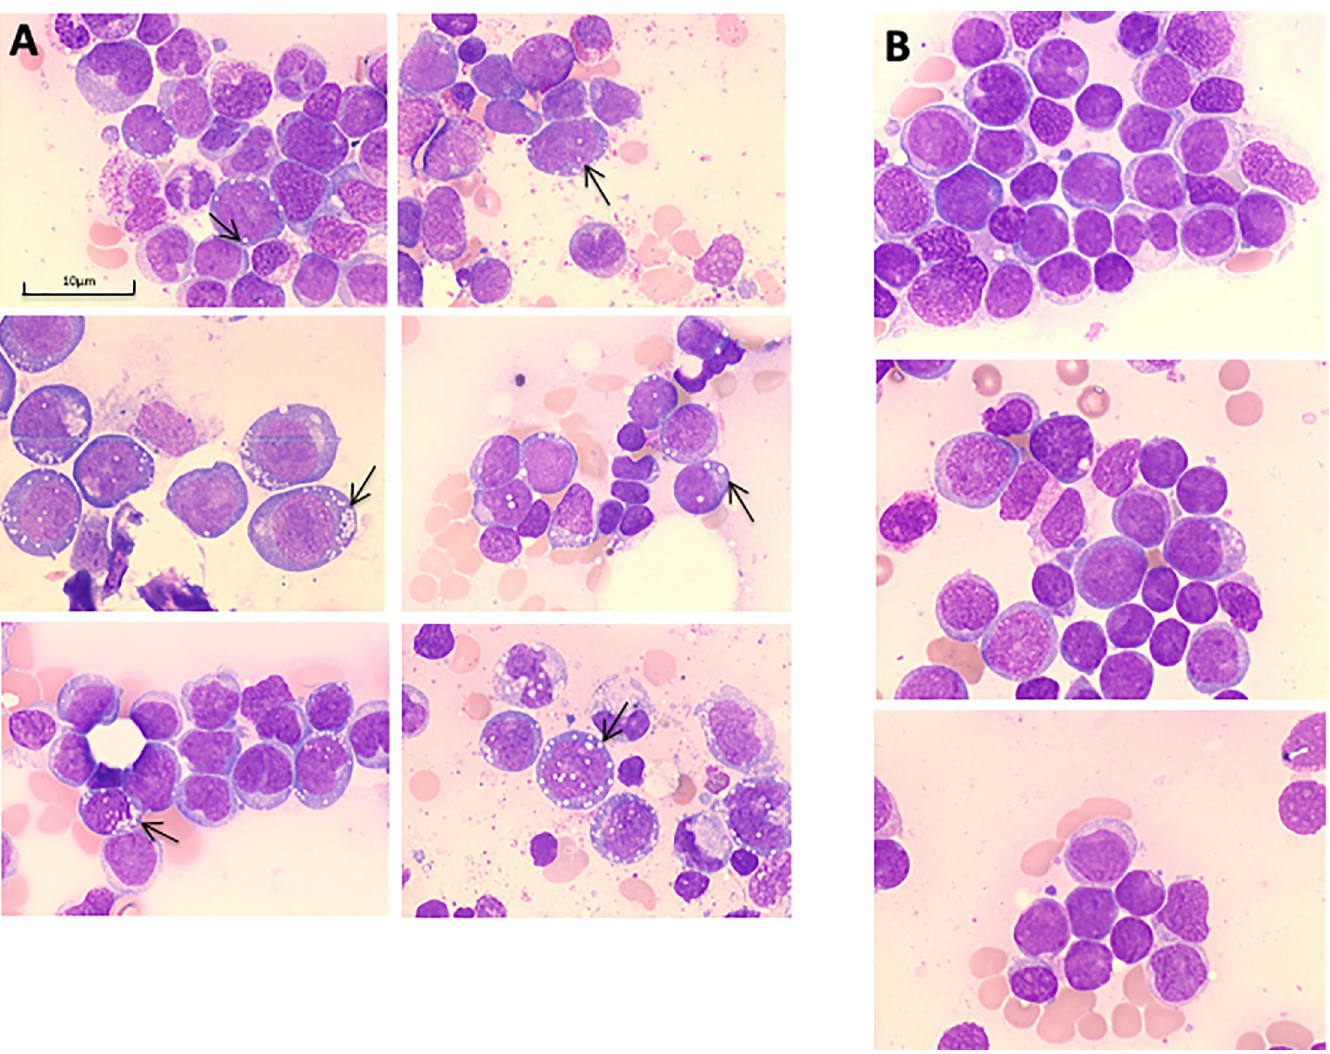
Fig 1. A. Typical morphology of bone marrow smears in Pappenheim staining from 6 individual AML patients with blast vacuolization. B. Typical morphology of bone marrow smears in Pappenheim staining from 3 regular AML patients without signs of blast vacuolization.